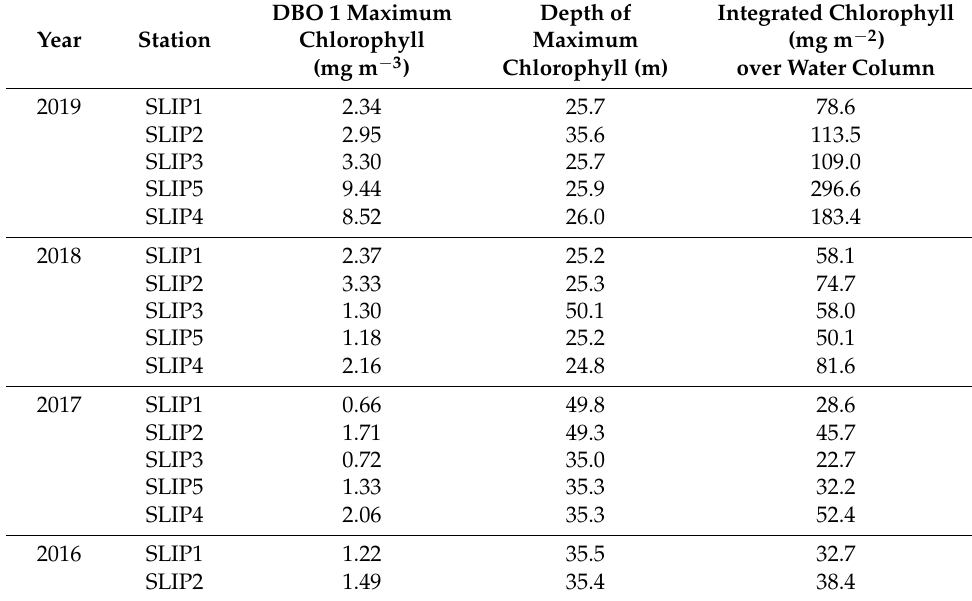
Table 1. DBO 1 Stations, south of St. Lawrence Island, 20-year time series for